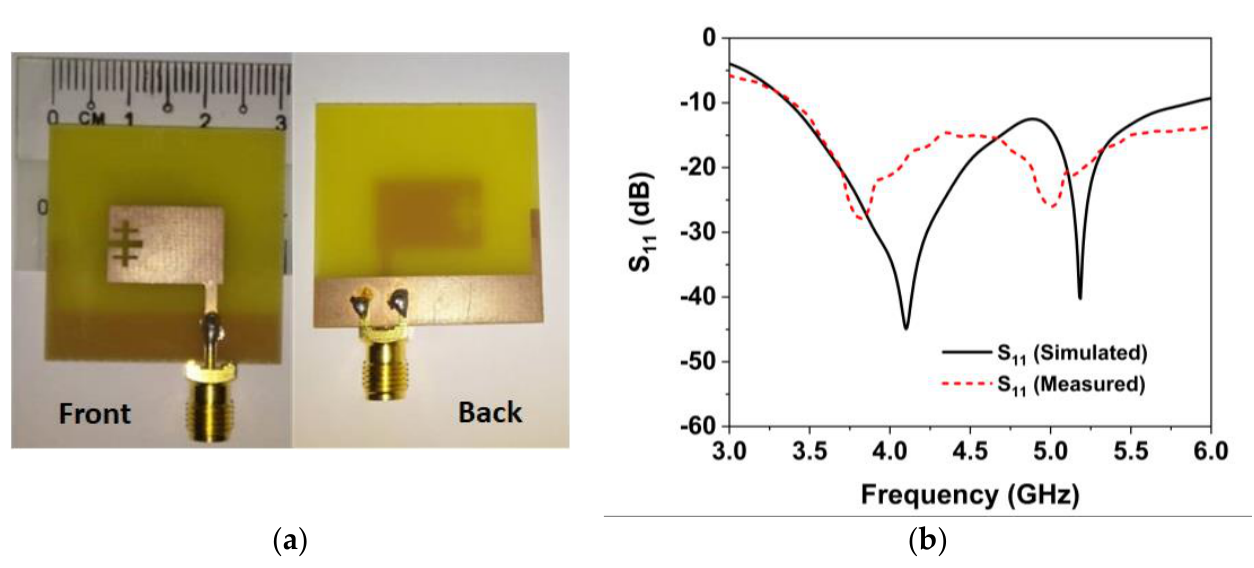
Figure 4. ( a ) Photos of the fabricated single antenna ( b ) Simulated and measured single antenna | S 11 | coefficients.